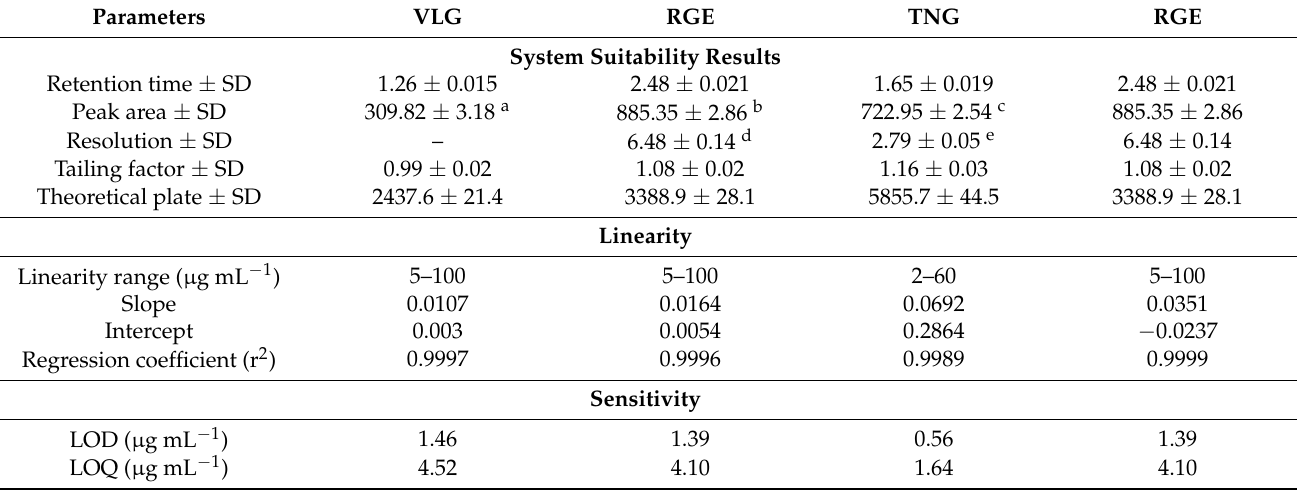
Table 3. System suitability and regression analysis